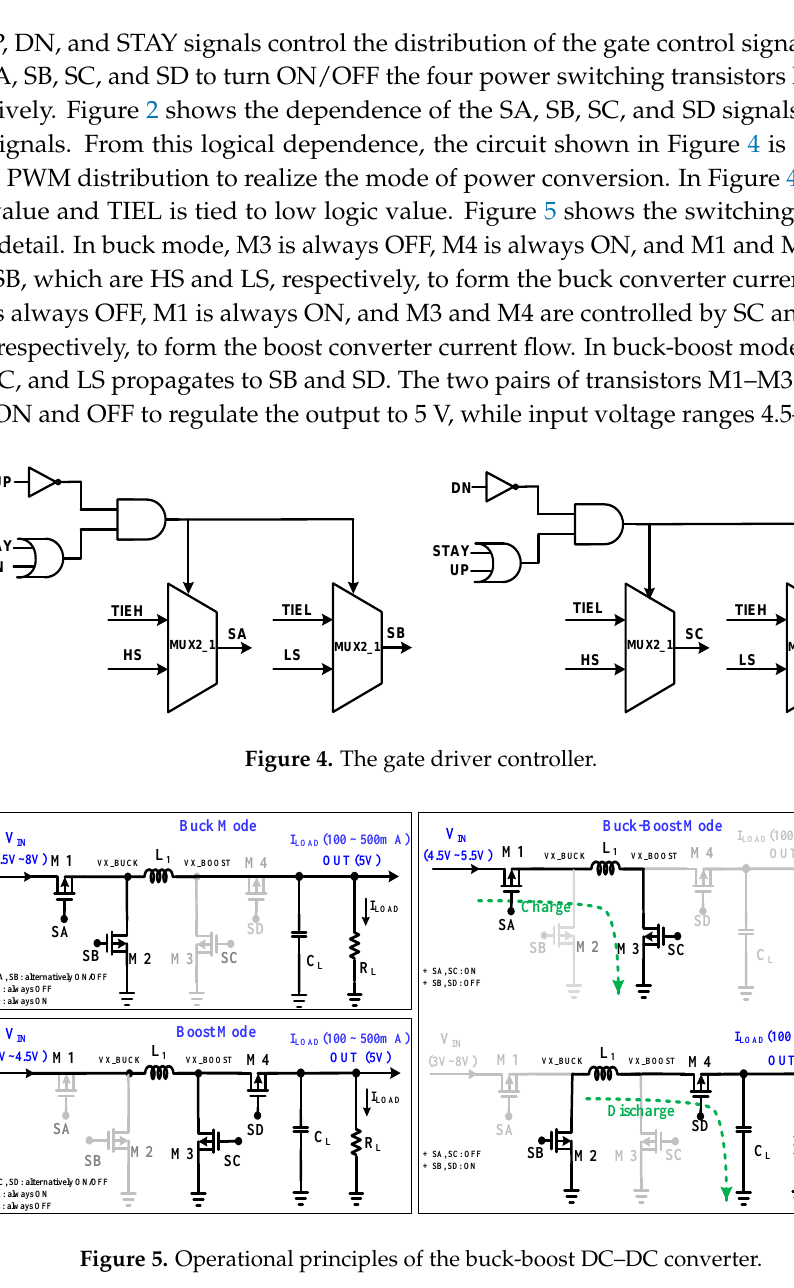
Figure 5. Operational principles of the buck-boost DC–DC converter.